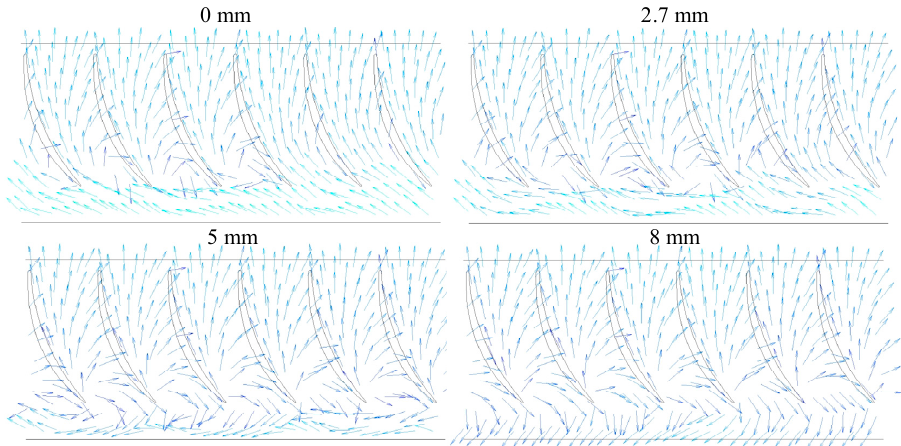
Figure 15. Velocity vectors at Span = 0.015 in guide vane passage with varying root clearances ( R t = 0 mm, 2.7 mm, 5 mm 8 mm; Q = 1.0 Q des ).